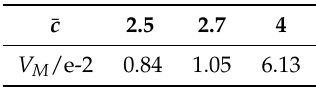
Figure 11. Example 5. Consider PI control of the higher order underdamped process model (Equation (48)). The figure illustrates the time-domain responses, given a prescribed robustness M s = 1.59, of following methods: the PO PI and the PRC + Algorithm 1 where the MP parameter setting ¯ c = 2.5 (proposed in Section 4) and RTDE δ = 2.20. An output disturbance unit step is presented at time t = 0 and an input disturbance unit step at time t = 80. Table 11. Example 5. The table shows the different MP parameter settings for the PRC + Algorithm 1 variant with corresponding main performance V M (Equation (42)).